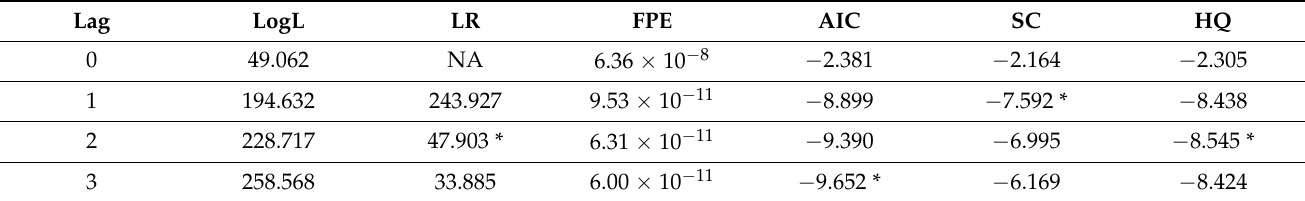
Table 6. Outcomes of optimal lag length criteria.